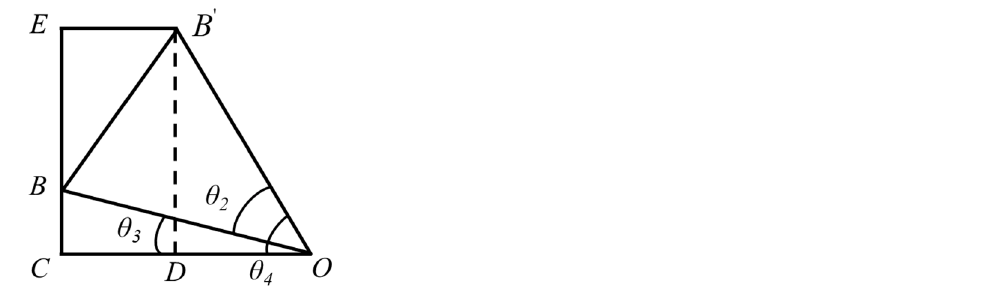
Figure 18. The geometric relationship between the guiding mechanism and the fastening bolt.